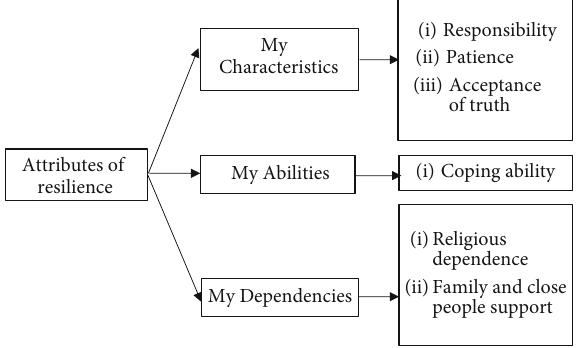
Figure 1: The components of